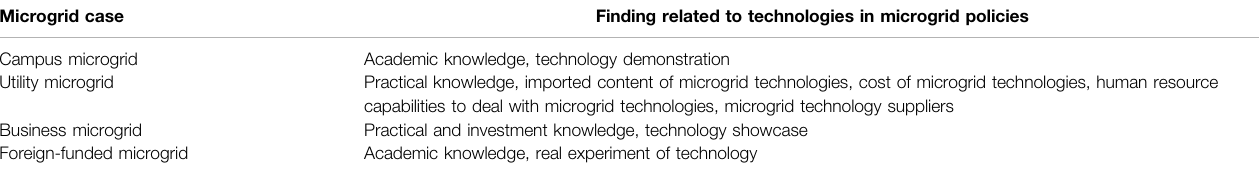
TABLE 1 | Findings related to microgrid technologies from a case of Thailand microgrids. Microgrid